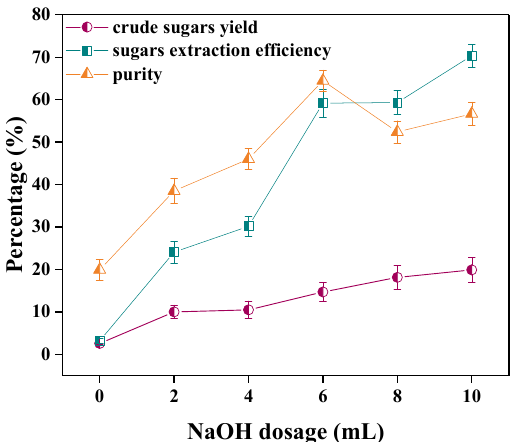
Figure 1. Effects of NaOH dosage on crude sugar yield, crude purity and sugar extraction efficiency.